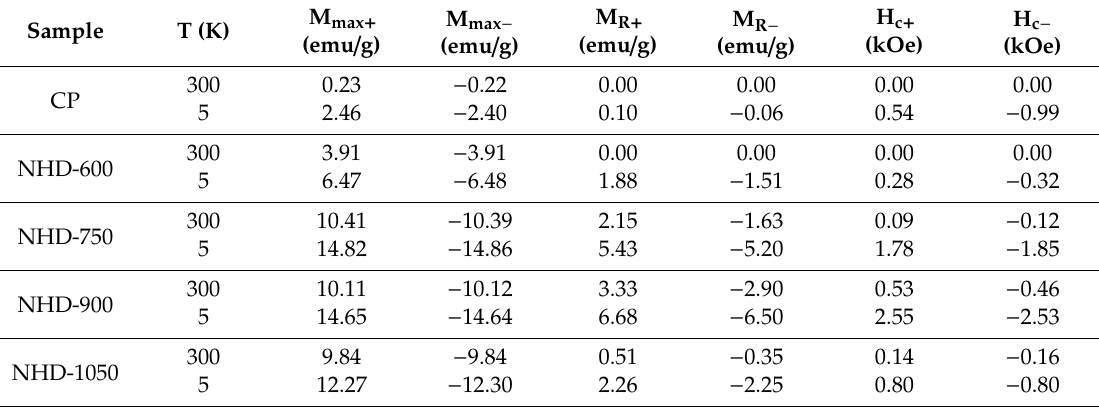
Figure 6. χ g vs. T measurements of the CP ( a ); NHD-600 ( b ); NHD-750 ( c ); NHD-900 ( d ) and NHD-1050 ( e ) samples collected under H = 1000 Oe following ZFC (red squares) and FC (blue circles) modes. Table 2. Isothermal hysteresis loops magnetic characteristics of the